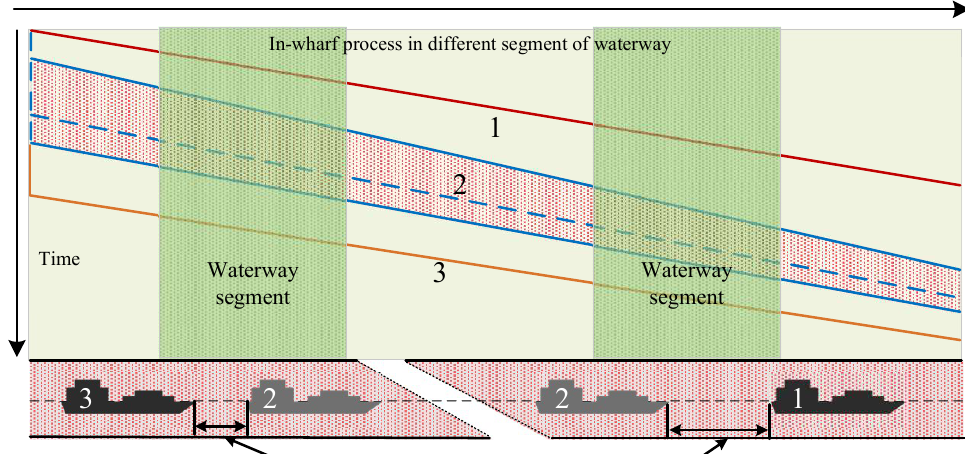
Figure 2. Simplified distance-time sketch with fuzzy